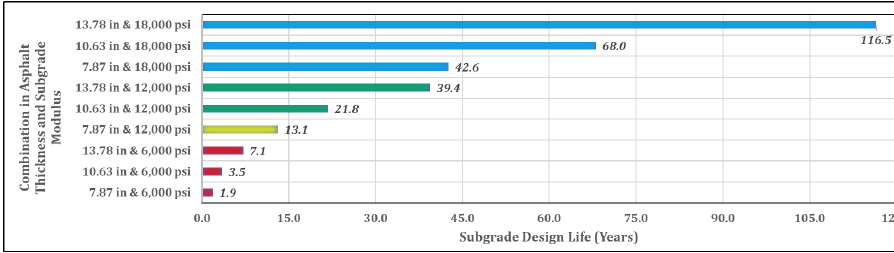
Figure 30: Influence of subgrade modulus and asphalt thickness on subgrade service life in asphaltic overlayment